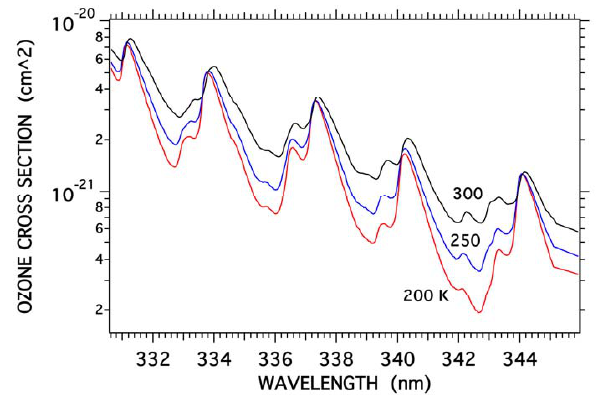
Fig. 3. Absorption cross-sections of ozone at 200, 250 and 300 K in the Huggins bands. In principle, observations of actual transmission spectra should enable retrieval of a temperature estimate.